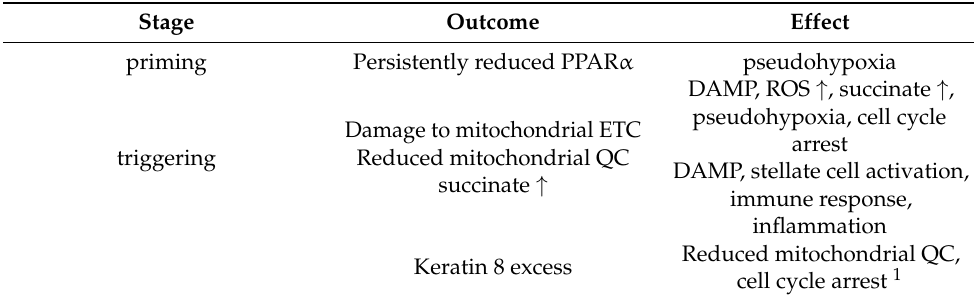
Table 3. Outcome of priming and triggering, leading to the